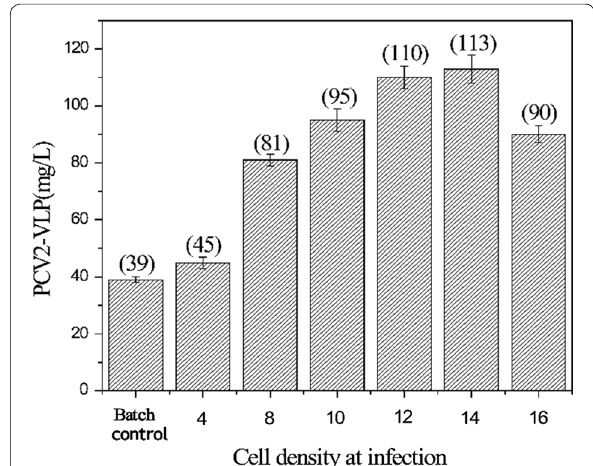
Fig. 5 Effects of cell density at infection (CDI) on PCV2-VLPs 10 6 cells/mL at an MOI of 1. × production in 1.5 L bioreactor fed-batch cultures. One feed was 10 6 cells/mL and × added to the cells at a cell density of 4.0 infected at different cell density ranging from 4.0 cells/mL. The batch control cells were infected at a CDI of 4 cells/mL. Values are an average of three independent experiments. Error bars represent standard